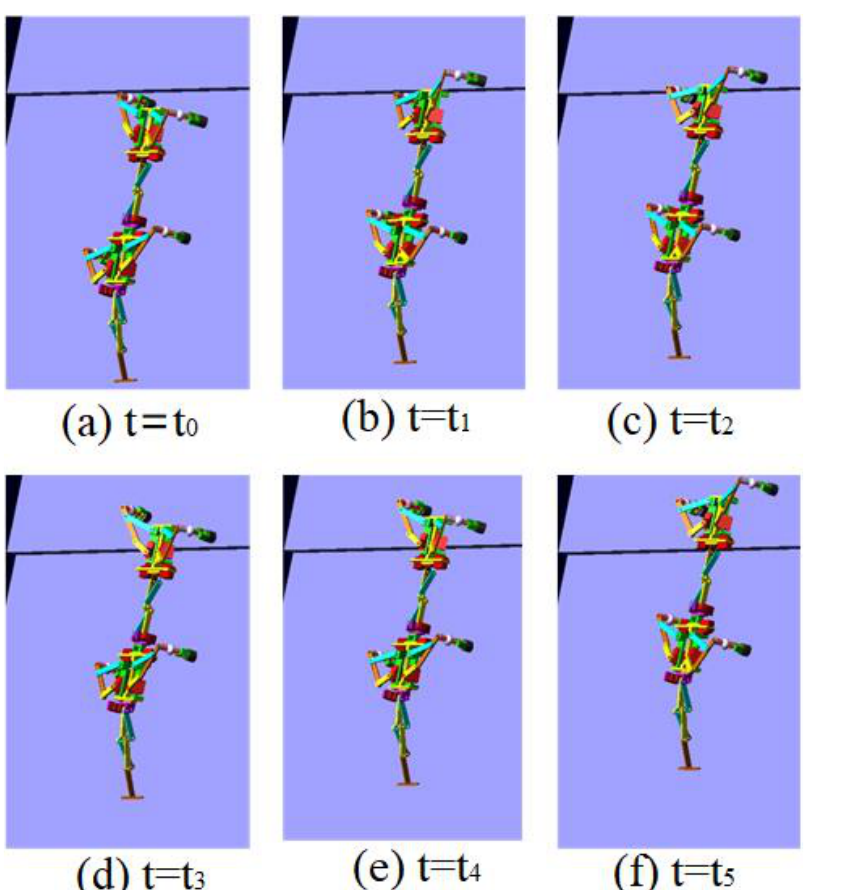
Figure 15. Movement of the robot using diagonal gait when climbing step in ADAMS in different moments.